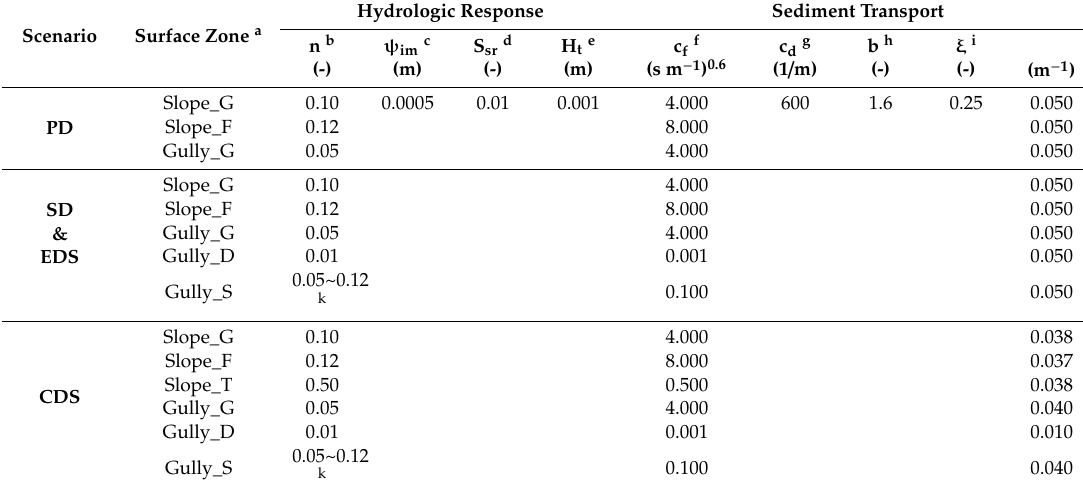
Table 4. Surface parameters used in InHM for the four